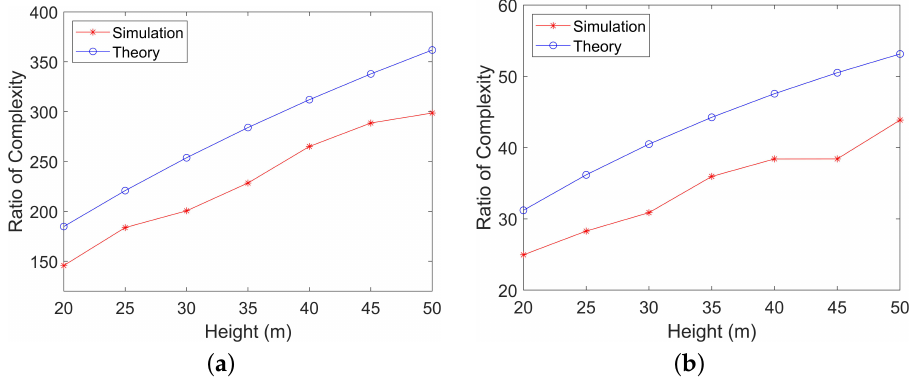
Figure 16. Comparison of the ratio of complexity between theoretical analysis and simulation. ( a ) First experimental configuration. ( b ) Second experimental